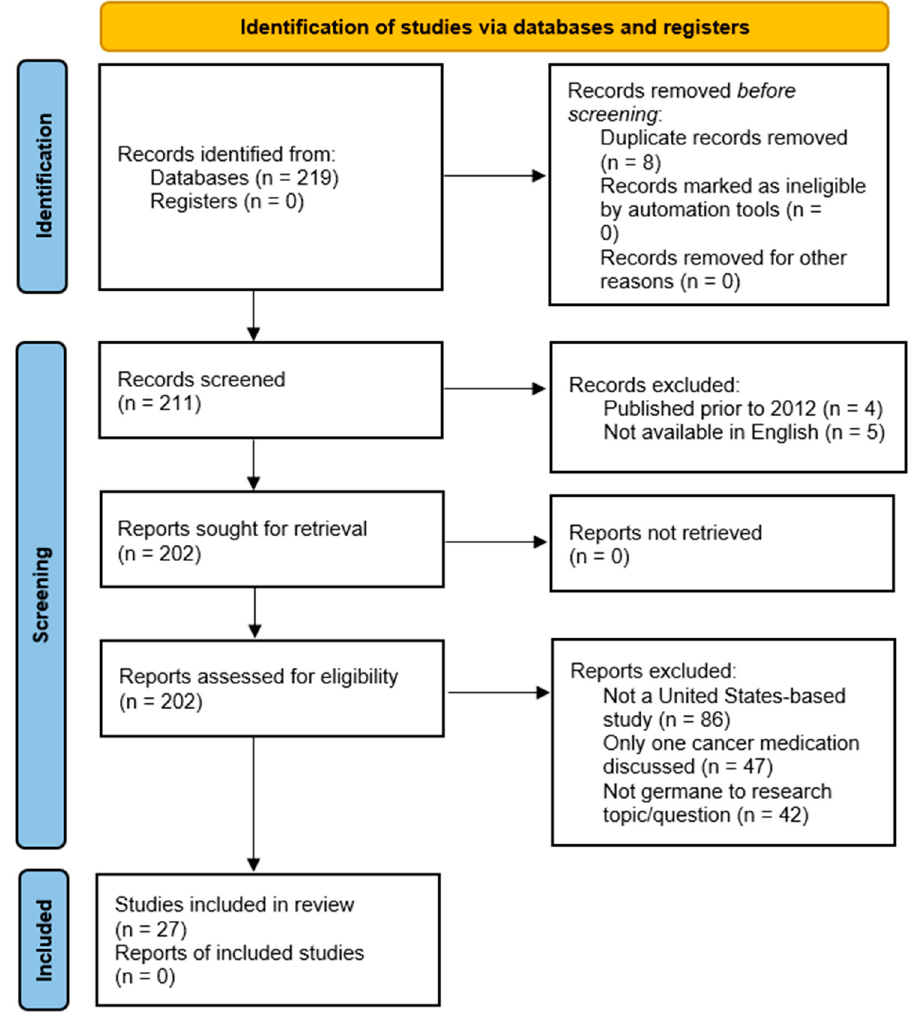
Figure 1. Preferred Reporting Items for Systematic Reviews and Meta-Analyses (PRISMA) flowchart demonstrating the study selection process. Table 1. Summary of findings ( n =